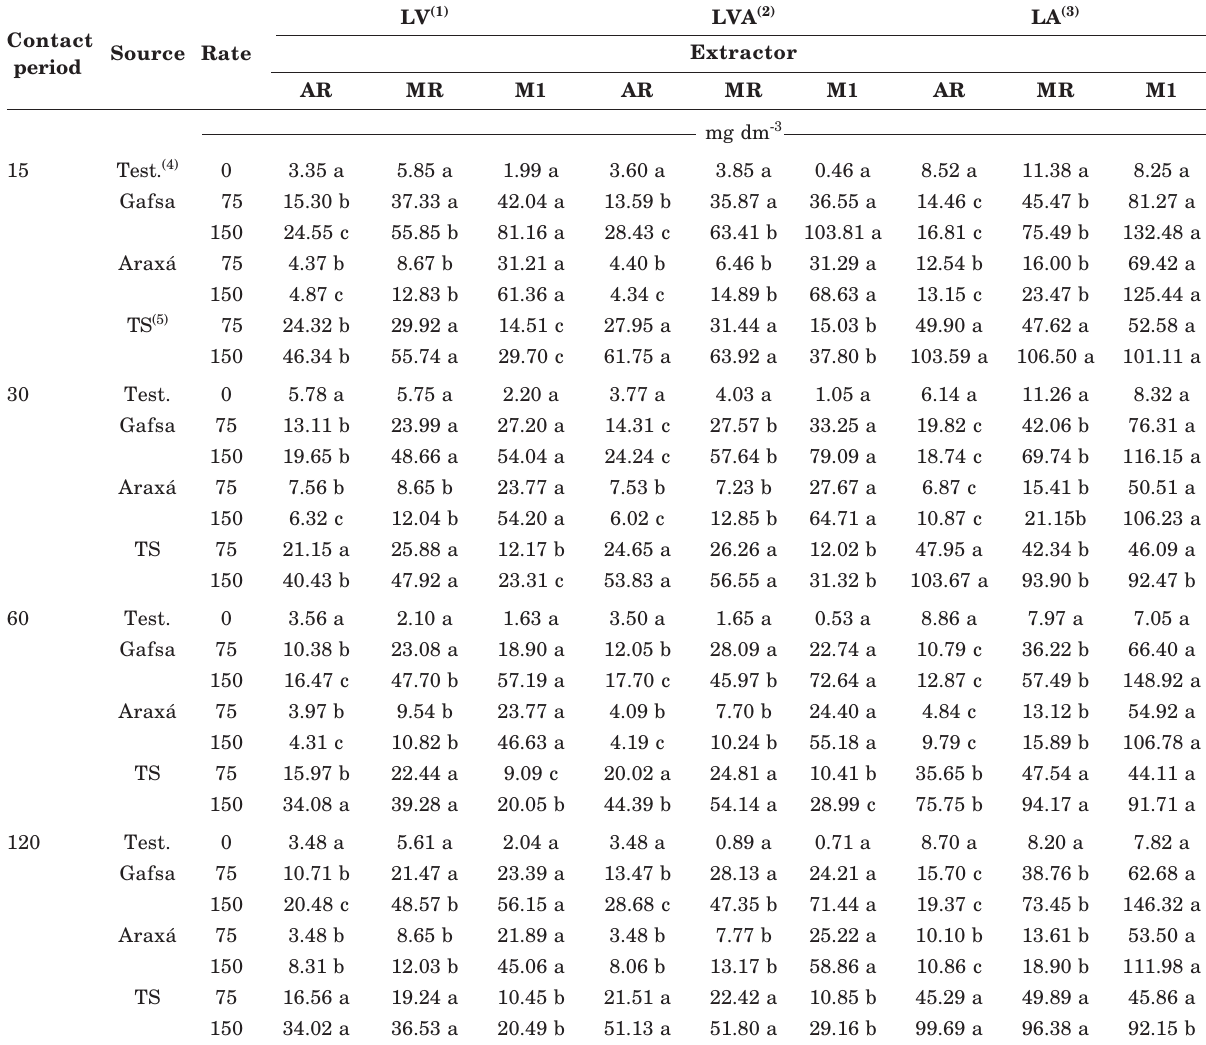
Table 3. Phosphorus contents determined after extraction with anionic resin (AR), mixed resin (MR) and Mehlich-1 (M1) in Latosols samples treated with P sources and levels, after different contact periods of the P sources with soil